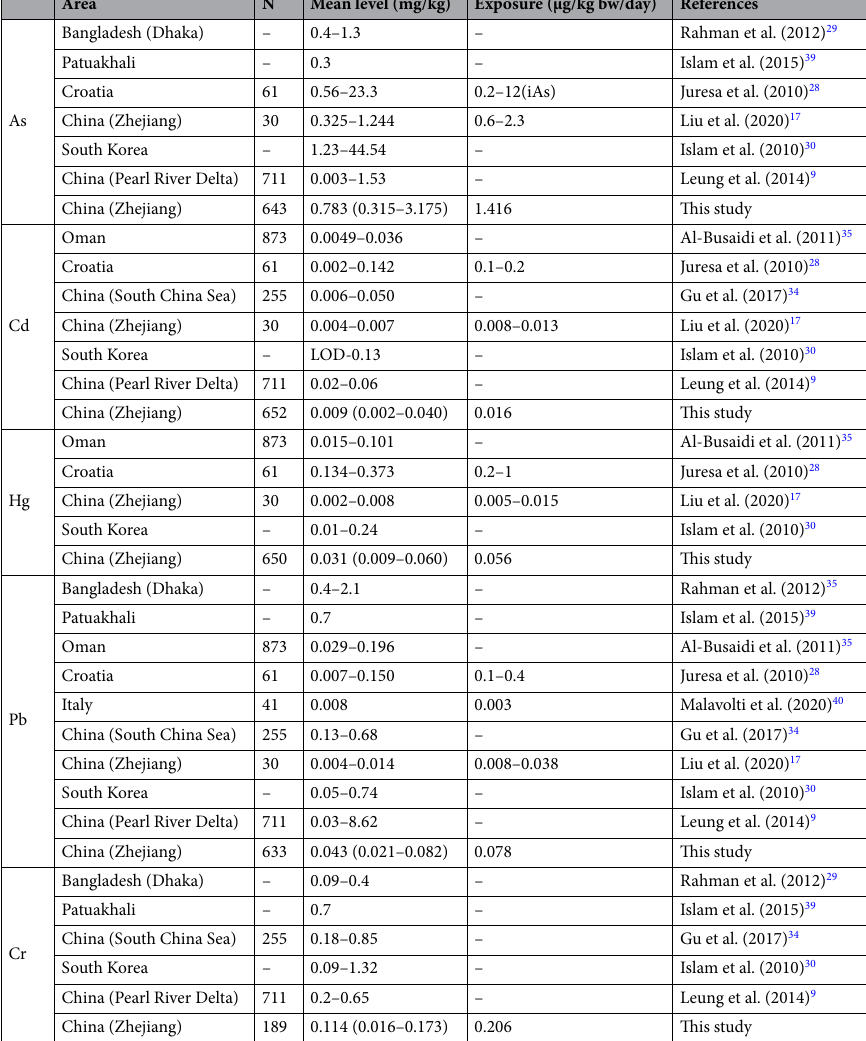
Table 3. Comparison of the levels of toxic elements in fish and exposure estimates to some previous